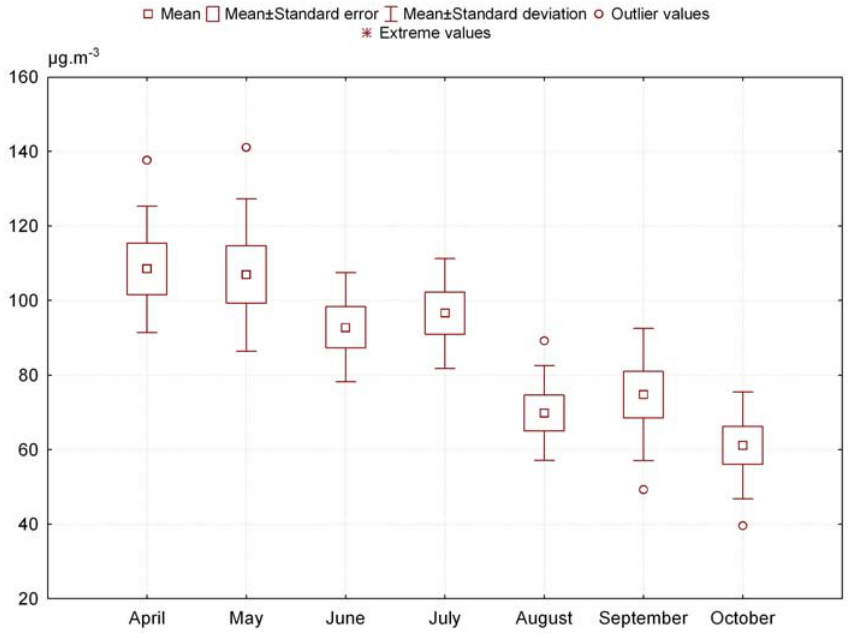
FIGURE 1 . Development of O 3 monthly mean concentrations at monitored localities.